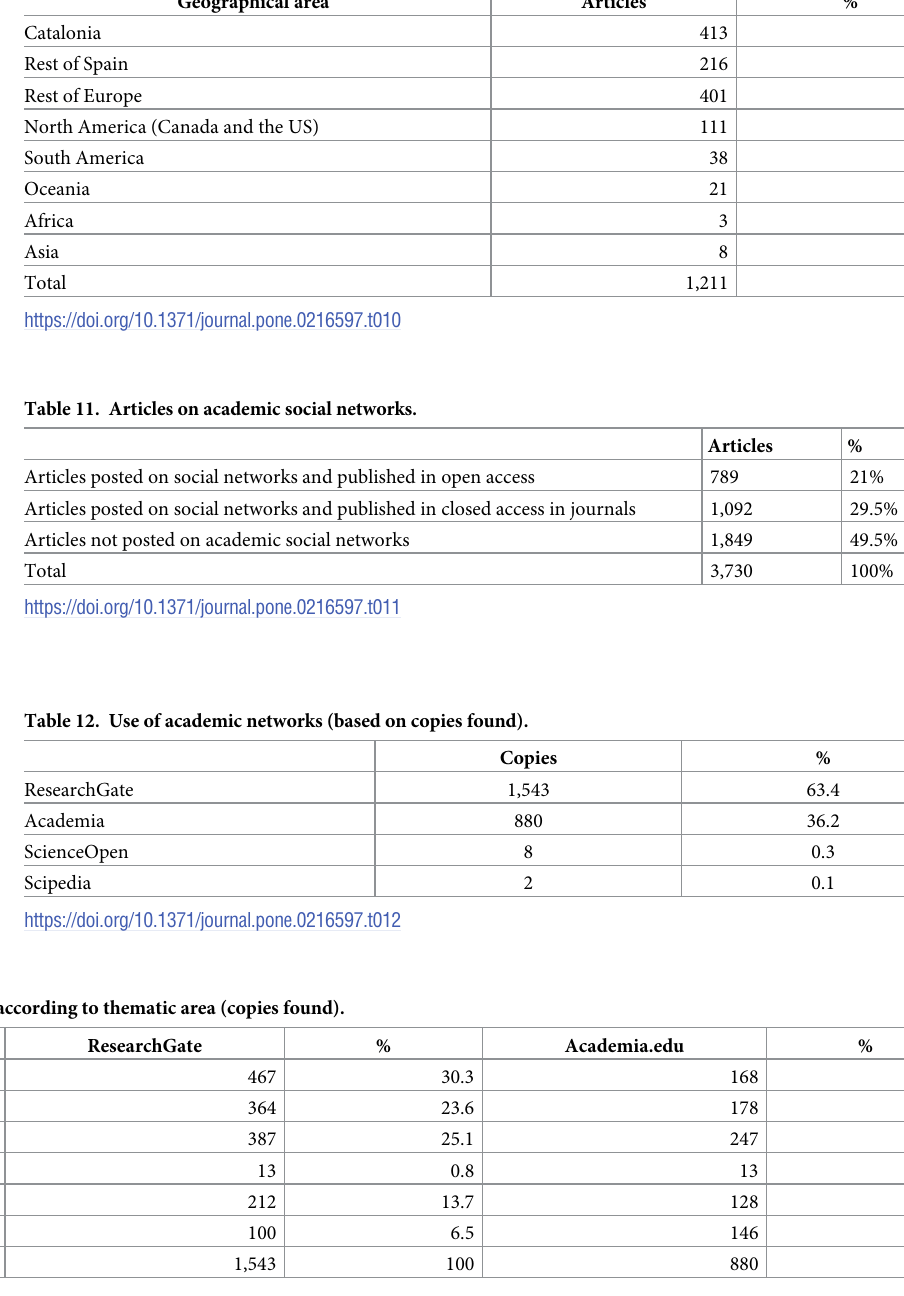
Table 10. Articles archived in repositories according to the geographical area of the repository. Geographical area Articles